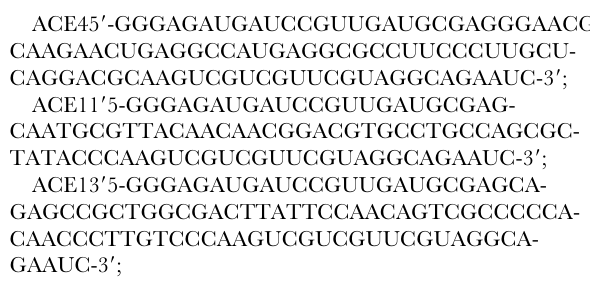
Figure 7. Tumor targeting of the ACE4 aptamer and scramble sequence measured by invivo fluorescence diffuse optical tomography (fDOT) imaging. 3 h post-intravenous injection, a fDOT imaging scan was performed in the tumor zone. A) Visualization in the Bird’s- eye view of the 3D reconstructed fluorescent signal in the tumor (color LUT) overlaid on the white light image of the mouse for the ACE4 aptamer (left panel) and the control sequence (right panel). B) Quantity of oligonucleotide inside tumors calculated from the 3D fluorescent signal A). Error bars represent standard deviation of triplicate. * P , 0.05.